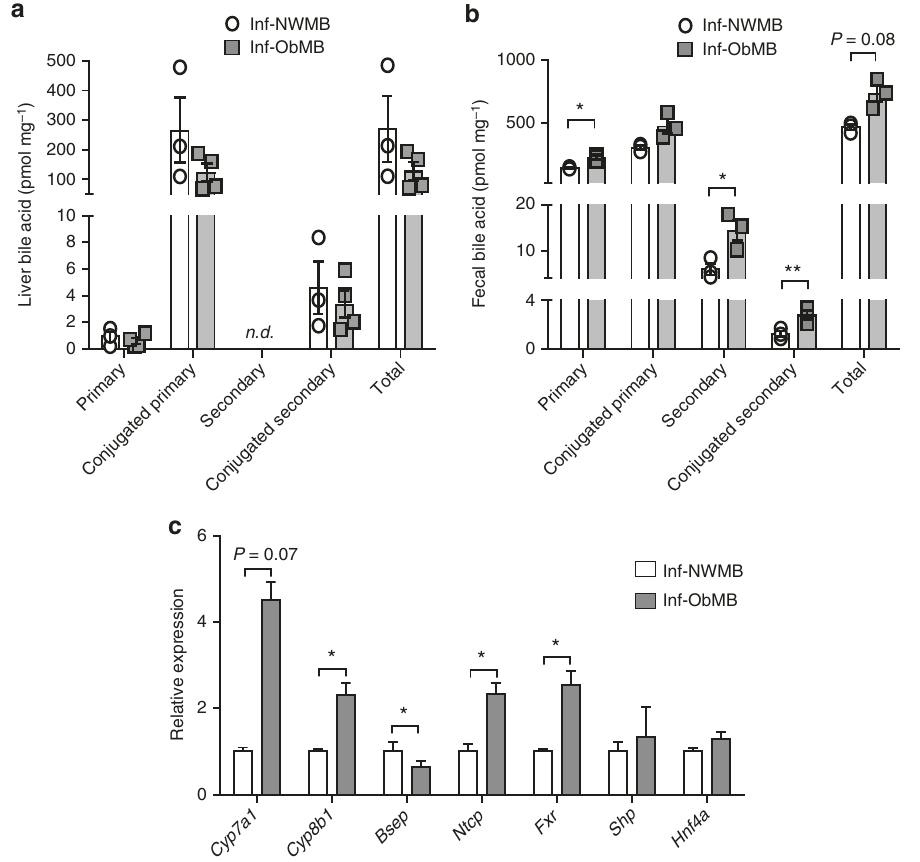
Fig. 3 Inf-ObMB increases fecal BA loss and alters hepatic BA homeostasis genes. Concentration of primary, conjugated primary, secondary, conjugated secondary, and total BAs in the liver ( a ) and feces ( b ) in Inf-NWMB and Inf-ObMB mice; n = 3 for Inf-NWMB, n = 4 for Inf-ObMB for liver; n = 3 for both Inf-NWMB and Inf-ObMB for feces. c Hepatic gene expression of BA synthesis enzymes Cyp7a1 and Cyp8b1 , exporter Bsep , importer Ntcp , BA receptor Fxr , and its downstream targets Shp and Hnf4a in Inf-NWMB and Inf-ObMB mice, normalized to Gapdh and 18S rRNA; n = 6 for Inf-NWMB, n = 7 for Inf-ObMB. Data are presented as mean ± SEM. * P < 0.05 and ** P < 0.01 by two-tailed Student ’ s t